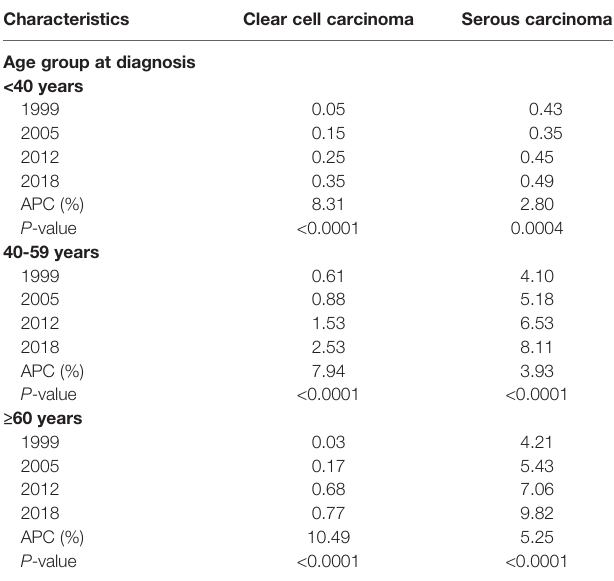
TABLE 2 | Age-speci fi c incidence of primary ovarian clear cell carcinoma and serous carcinoma in Korea.